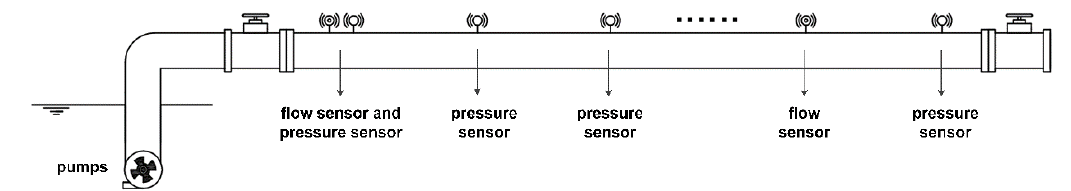
Figure 1. Diagram of a water delivery pipeline.